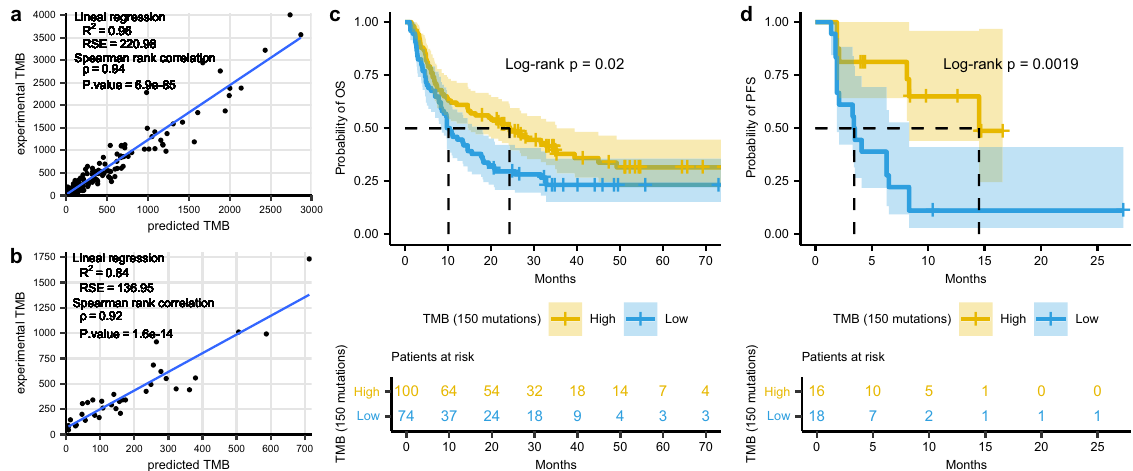
Fig. 4 Predicted TMB and response to immunotherapy. a , b Correlation between experimental TMB and the TMB predicted according to our suggested panels for two reported cohorts of ( a ) melanoma ( n = 174) and ( b ) NSCLC ( n = 34) patients treated with ICB therapy (two melanoma samples with >6000 mutations are omitted for clarity). c Kaplan – Meier plot of OS in the 174 metastatic melanoma patients, strati fi ed according to predicted TMB (cut-off, 150 mutations). d Kaplan – Meier plot of PFS in the 34 advanced NSCLC patients, strati fi ed according to predicted TMB (cut-off, 150 mutations).